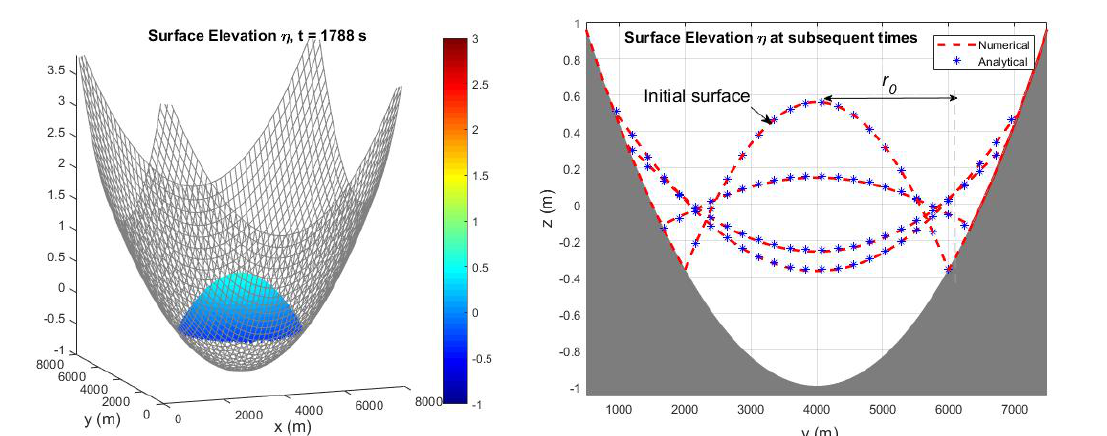
Figure 3. Surface oscillation at subsequent times t = T /6, T /3, T /2, T , with period T = 1795.2